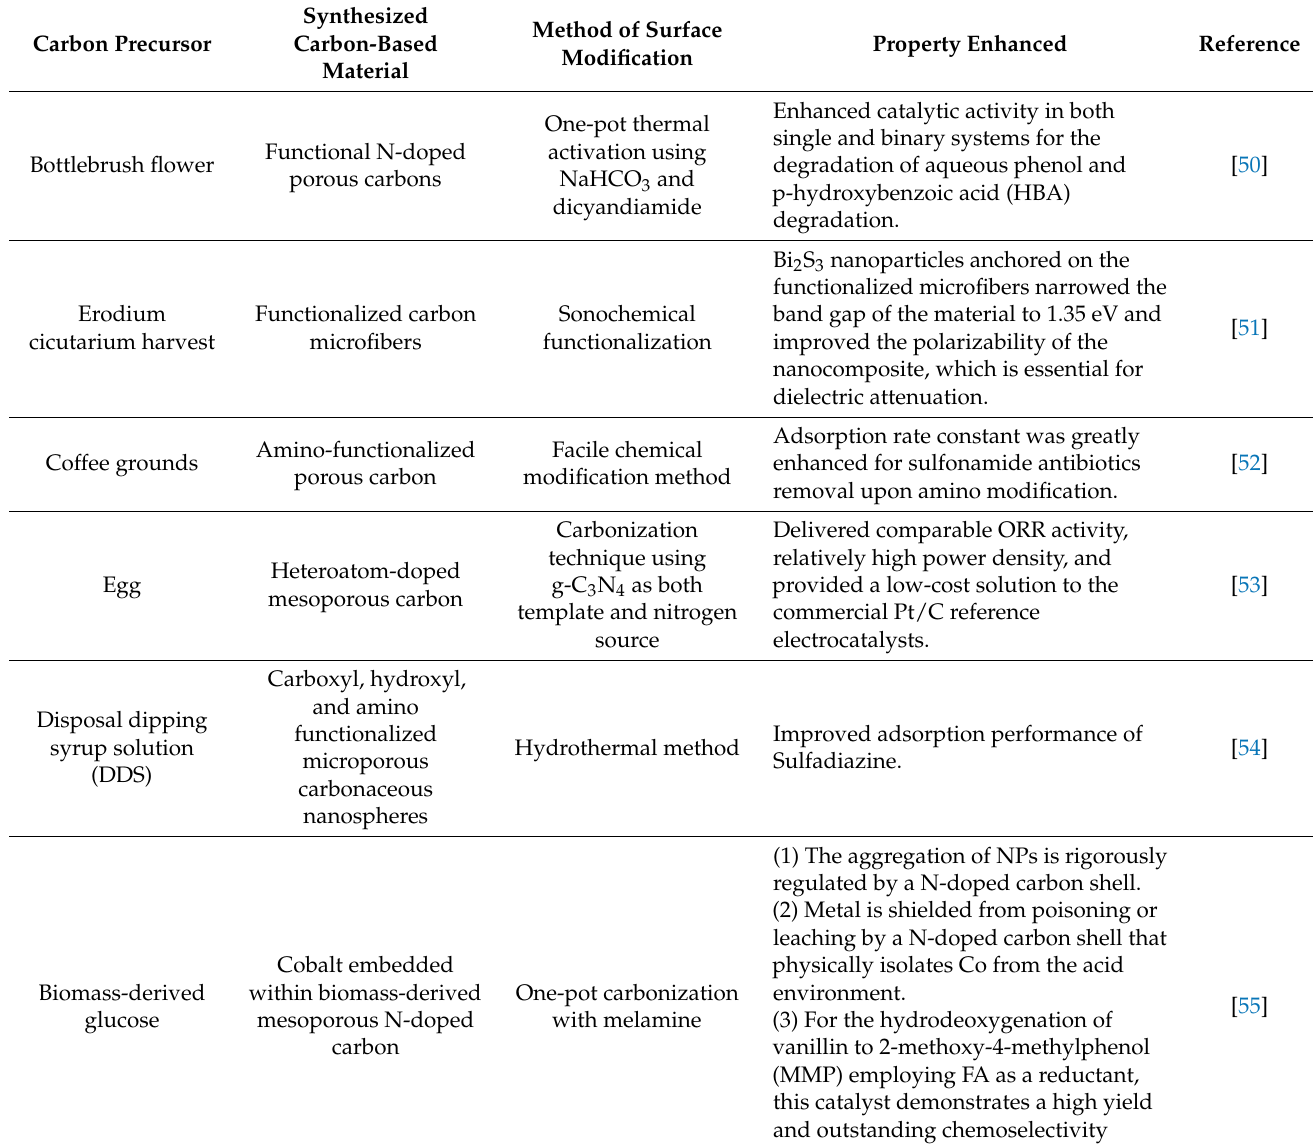
Figure 12. Surface functional groups that act as anchoring sites for catalyst precursors or active sites for catalysis on porous carbons. Adapted with permission from ref. [45]. Table 1. Property enhancement due to surface